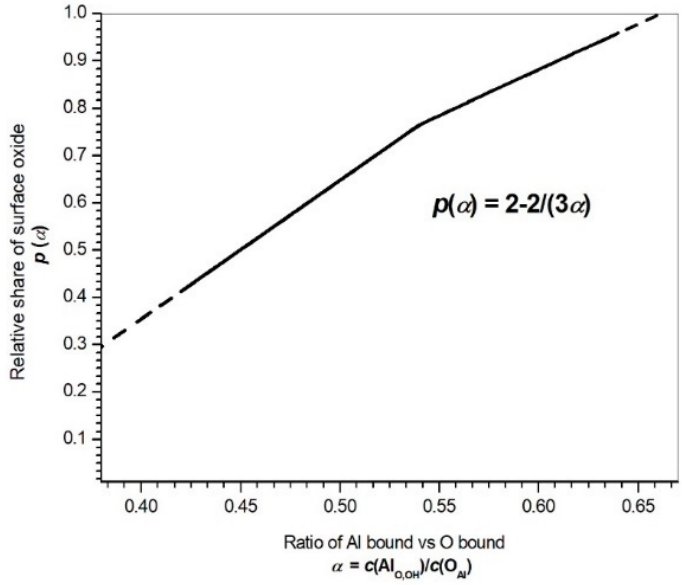
Figure 6. Share of surface oxide p( α ) vs. ratio of Al and O bound in oxide/hydroxide, α . The Al hydroxide ( 1 − p ) on the freshly cut surface is virtually non-existent (1 − p = 0.04), which agrees with previous investigations [43]. It forms, however, a significant part of the oxide/hydroxide layer on the undegraded area and even more significant part of the degraded area (see Table